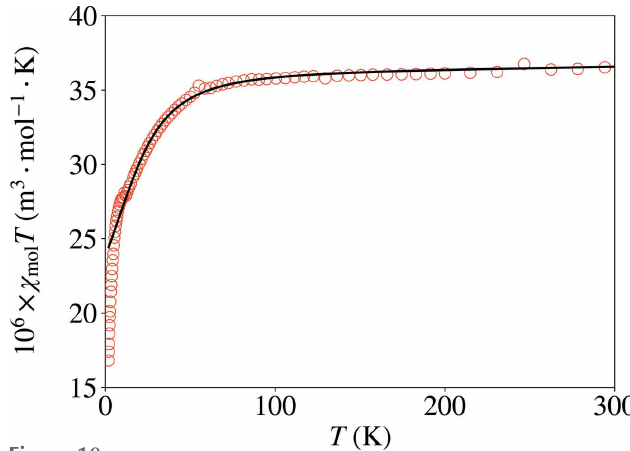
Figure 10 Temperature dependence of (cid:5) T for Co(Pmhpz)Cl 2 . The solid line is the fit using an exact diagonalization method, between 12.5 and 310 K. (Note that the usual units for molar susceptibility (cid:5) have been replaced here by